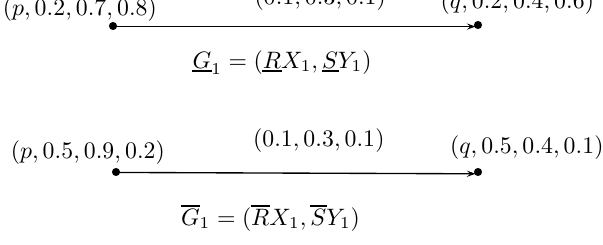
Figure 8. Neutrosophic rough digraph G 1 = ( G 1 , G 1 ) .